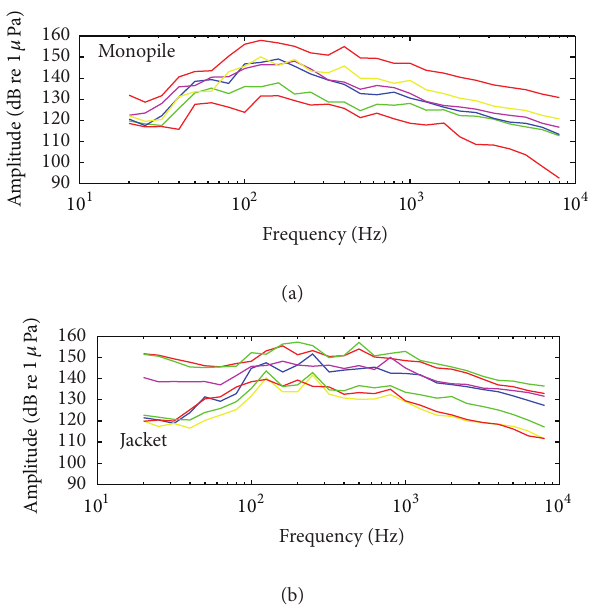
Figure1:1/3octavespectraoftheunderwaternoiseoftheBlighbank monopiling and the C-Power jacket piling.